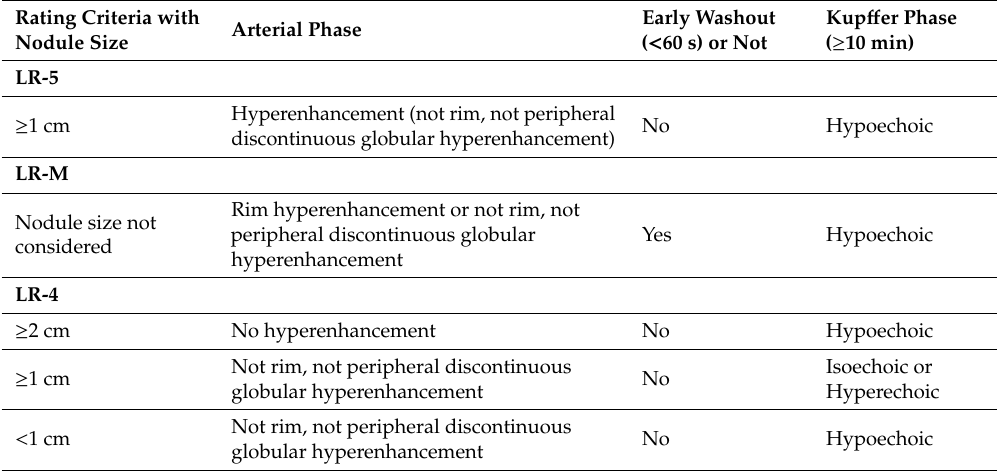
Table 1. Modified Contrast-Enhanced Ultrasound Liver Imaging Reporting and Data System (CEUS LI-RADS) criteria.